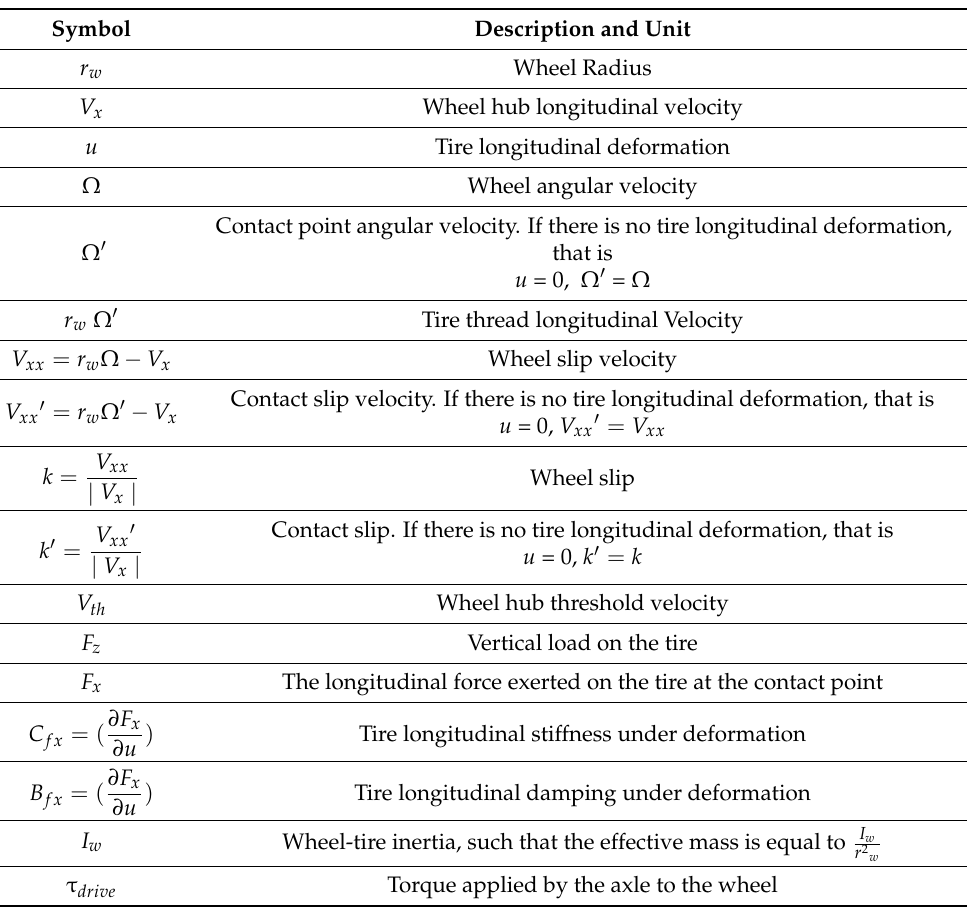
Figure 2. Tire model with wheel variables [24]. Table 1 defines the tire model variables [25]. Table 1. Parameters to calculate slip of tire.